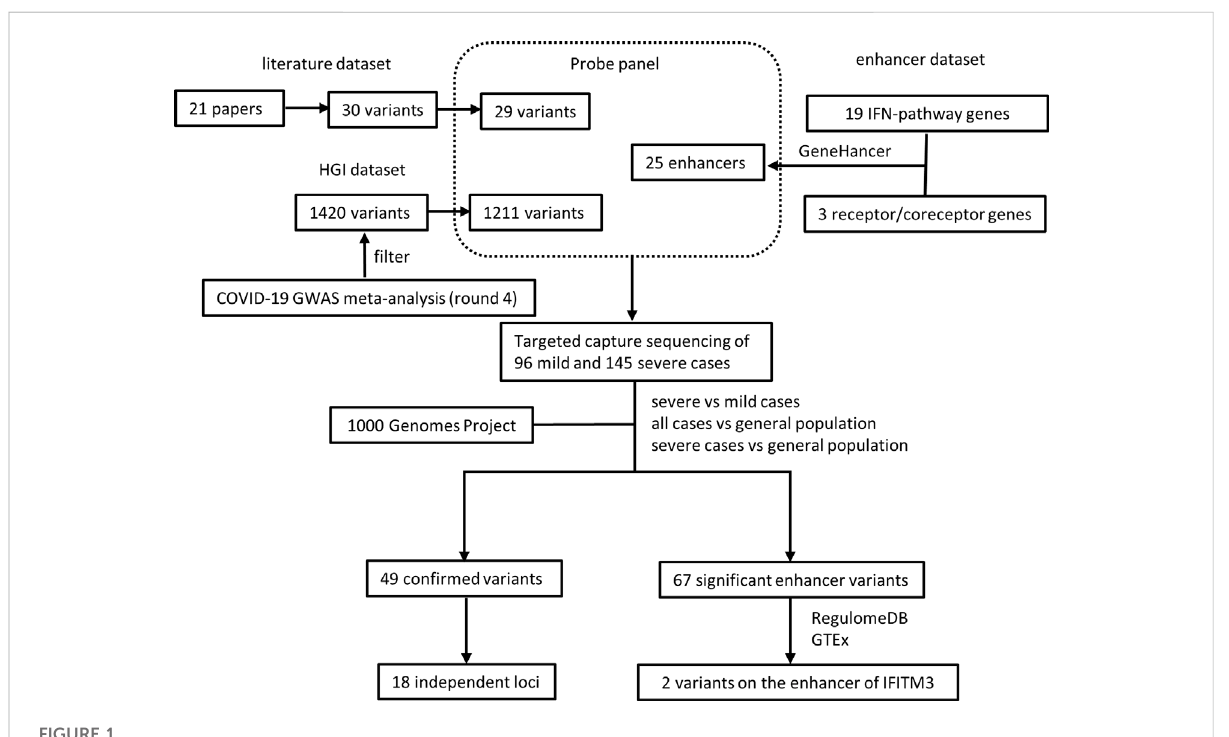
FIGURE 1 Illustration of experimental design and